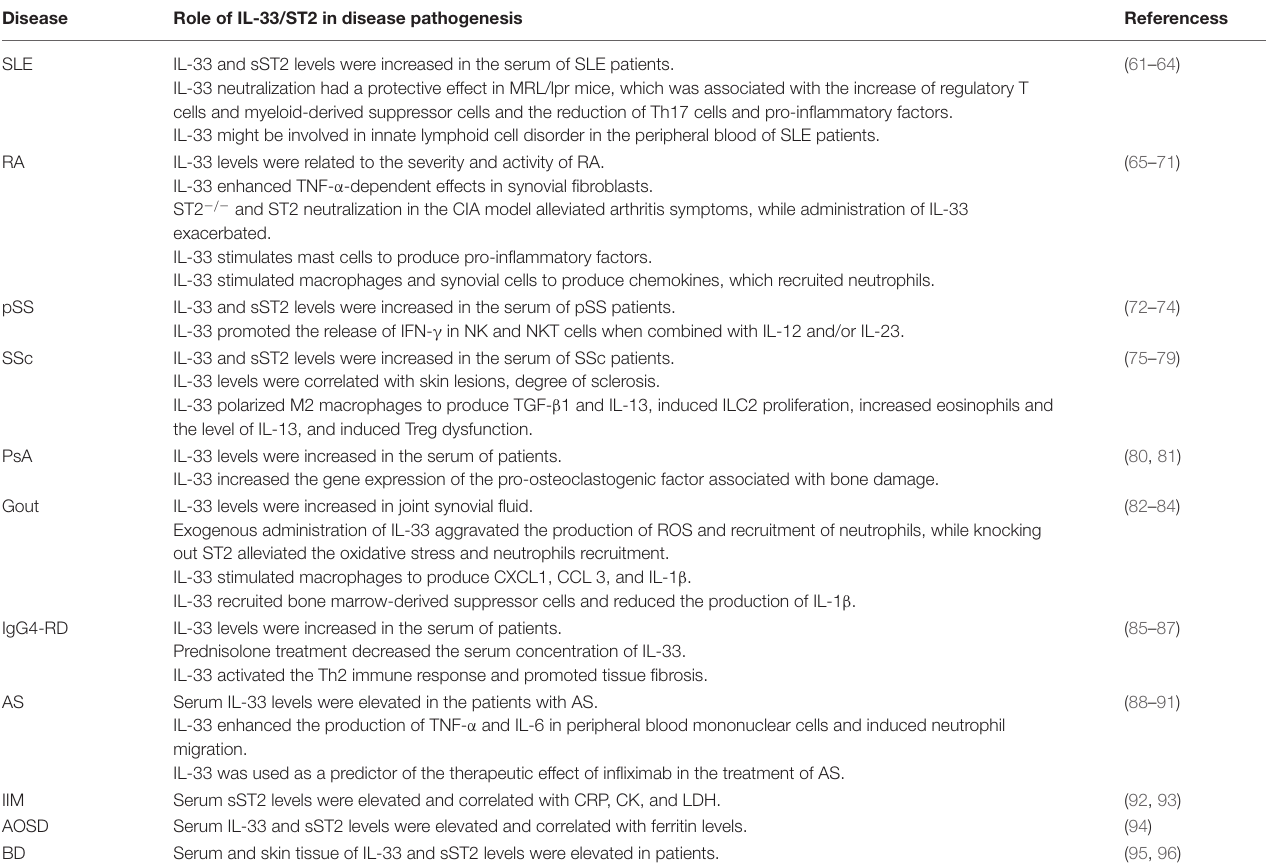
TABLE 1 | Expression and mechanisms of IL-33/ST2 in rheumatic diseases. Disease Role of IL-33/ST2 in disease